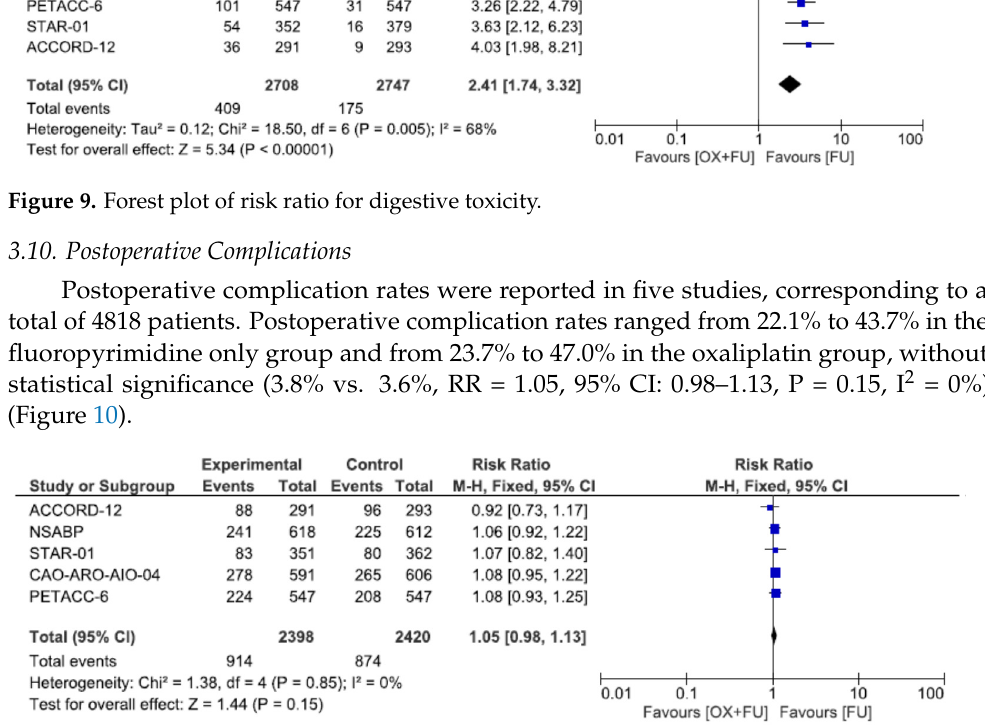
Figure 10. Forest plot of risk ratio for postoperative